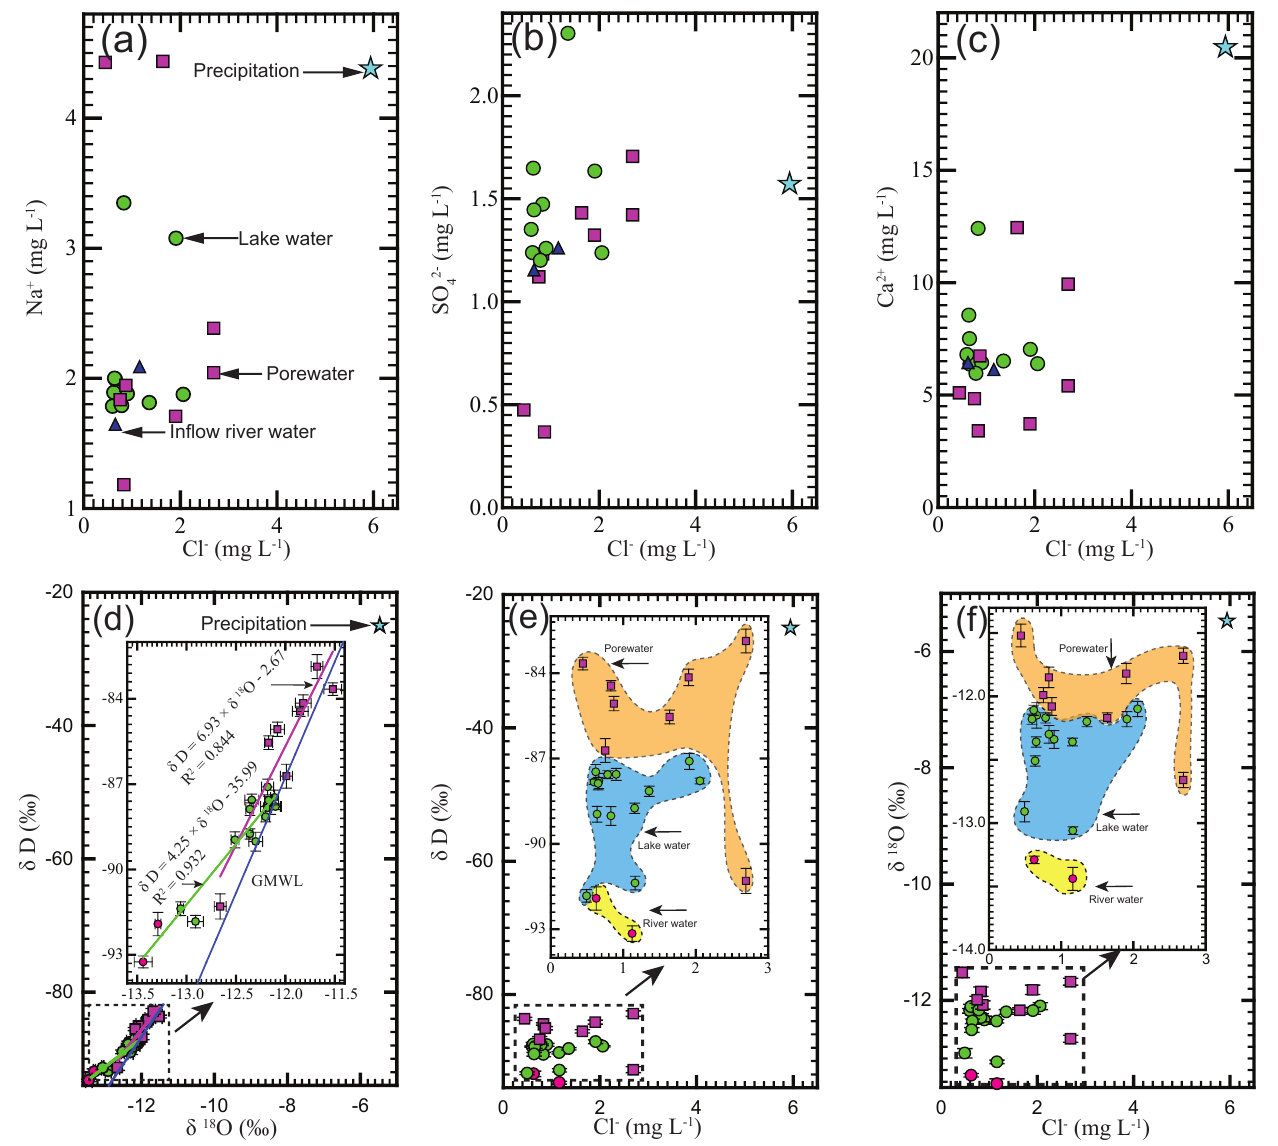
Figure 4. The cross plots of Cl − versus Na + (a) , SO 2 − versus 2 H (e) , and Cl − versus 18 O (f)